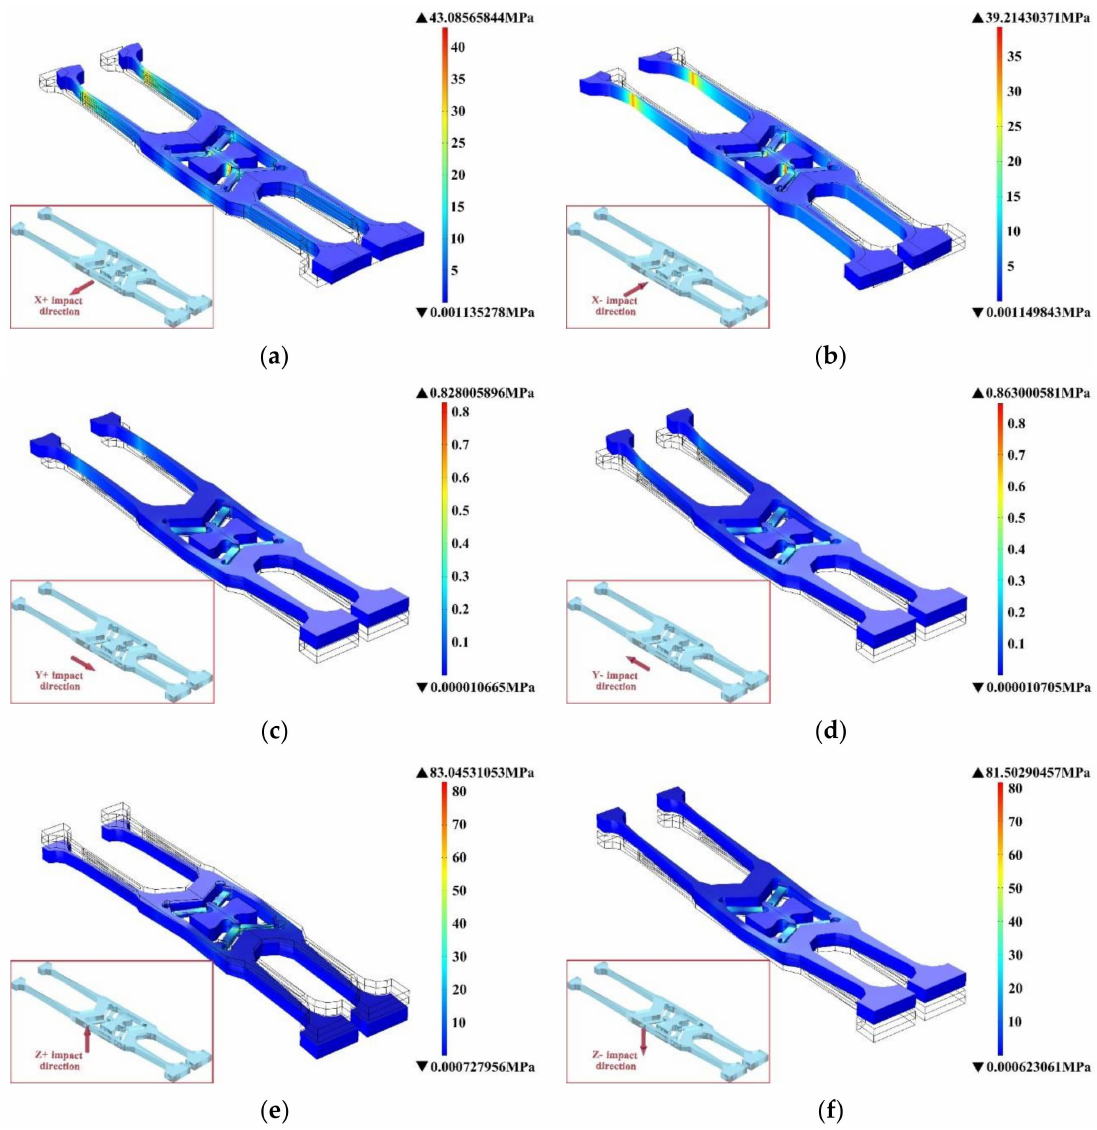
Figure 17. The stress contour with V-shaped beam thickness of 100 µ m after exerting ( a ) X + shock direction, ( b ) X − shock direction, ( c ) Y + shock direction, ( d ) Y − shock direction, ( e ) Z + shock direction, and ( f ) Z − shock direction. Table 3. Maximum stress in six shock directions of shock response